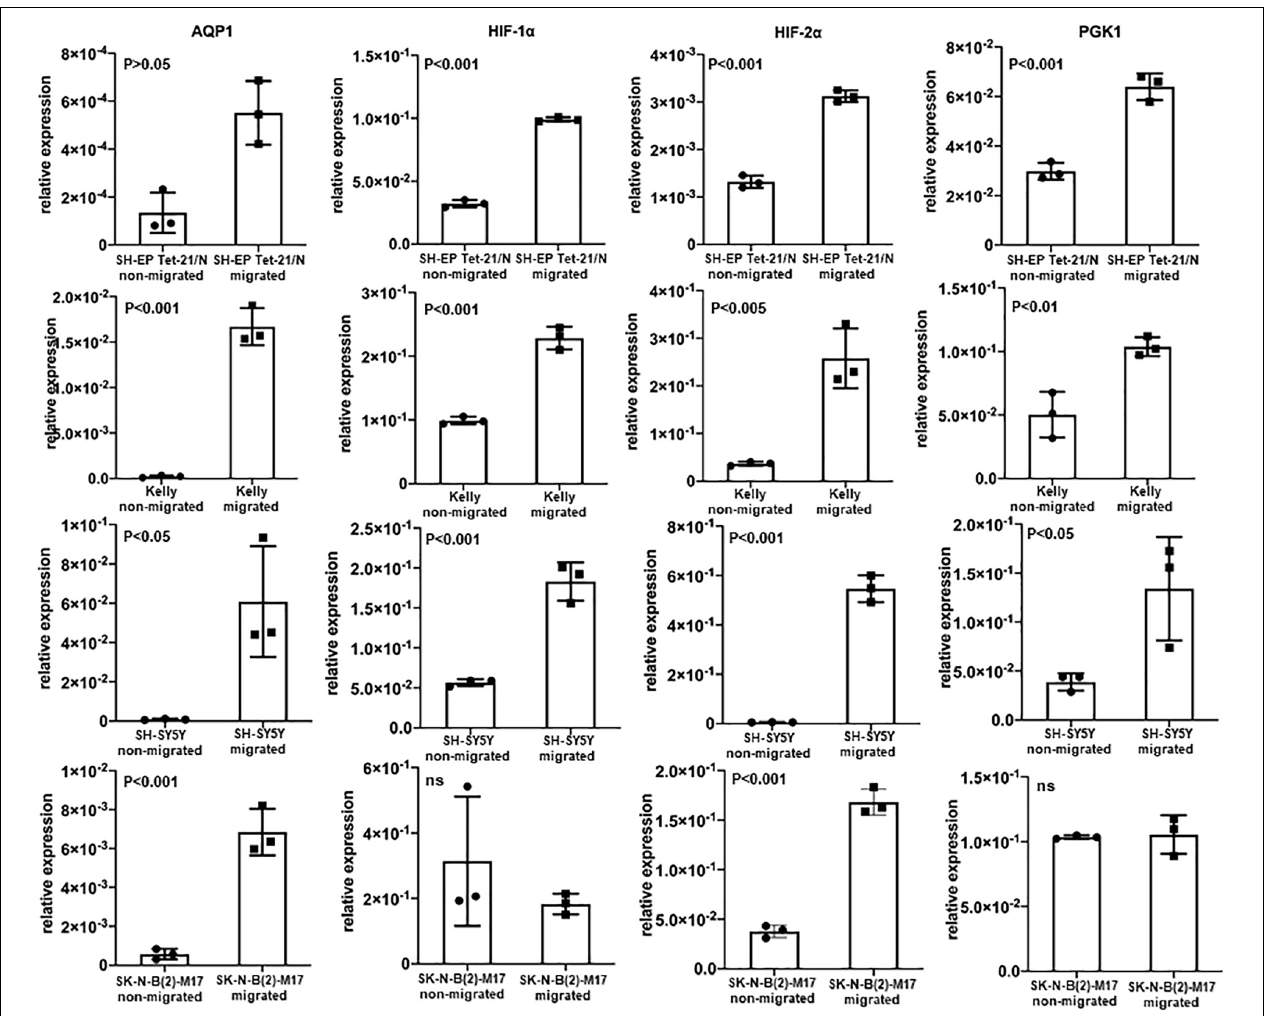
FIGURE 3 | AQP1 expression of non-migrating and migrating cells and expression of hypoxia-related profile. Evaluation of AQP1 mRNA after selection of cells that have actually migrated and those which have not migrated in a transwell assay show an elevated expression of AQP1 in the migrated cells (first vertical column). This becomes very clear when looking at Kelly and SH-SY5Y cells. But also in cell lines SK-N-B(2)-M17 and SH-EP Tet-21/N, in which we did not detect large amounts AQP1 mRNA under hypoxia, there are significant differences between migrated and non-migrated cells, however with a lower relative expression (y-axis). A significantly increased expression can is also observed for HIF-1 α (second vertical column), HIF-2 α (third vertical column) and PGK1 (fourth vertical column) in migrated cell lines, with the exception of HIF-1 α and PGK1 in SK-N-B(2)-M17. The experiment was performed twice, RNA triplicates were used for qPCR analysis each time and student’s t -test for analysis of